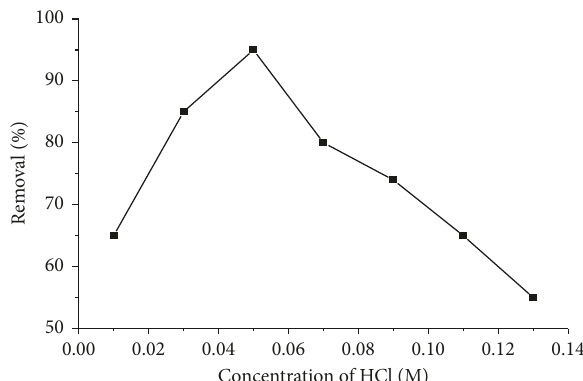
Figure 16: The cyclic adsorption performance of the adsorbent GO against F − .